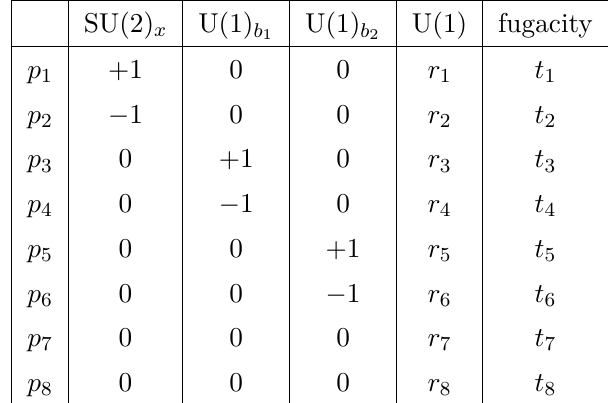
Table 67 . Global symmetry charges on the extremal brick matchings p i of Model